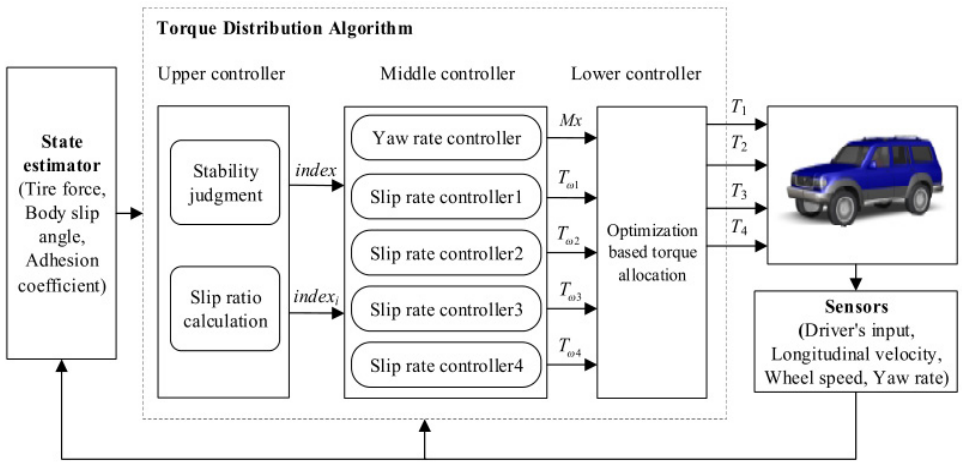
Figure 5. Schematic diagram of the torque distribution algorithm.